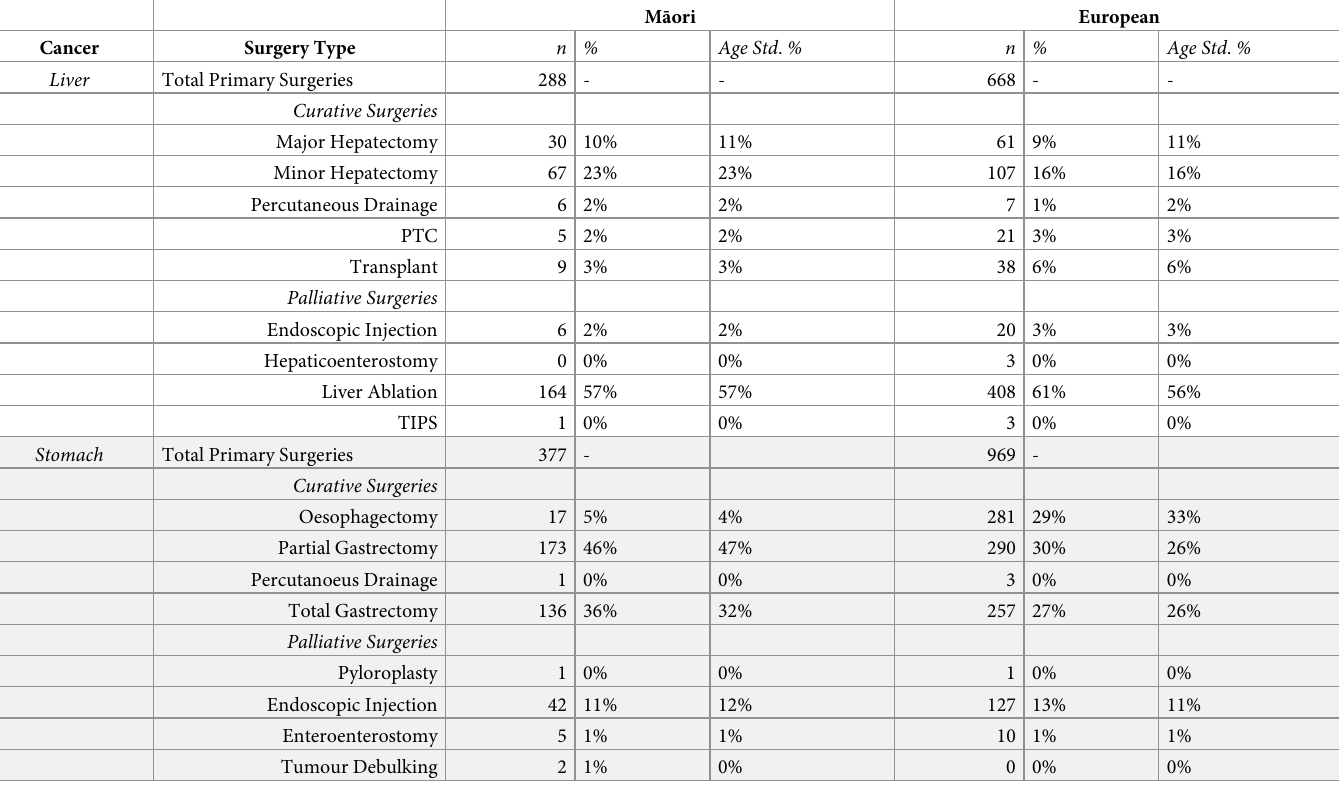
Table 1. Frequencies and proportions (crude and age-standardised) of first primary curative or palliative surgery for liver and stomach cancer, stratified by ethnicity. M ā ori European Cancer Surgery Type n % Age Std . % n % Age Std .